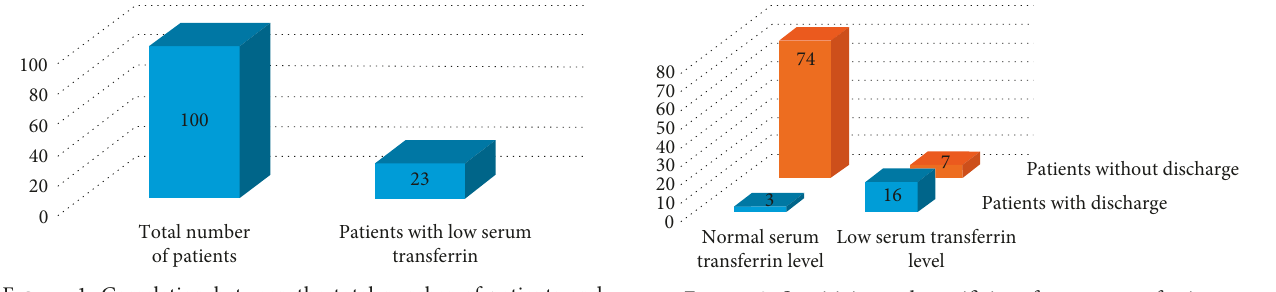
Figure 3: Sensitivity and specificity of serum